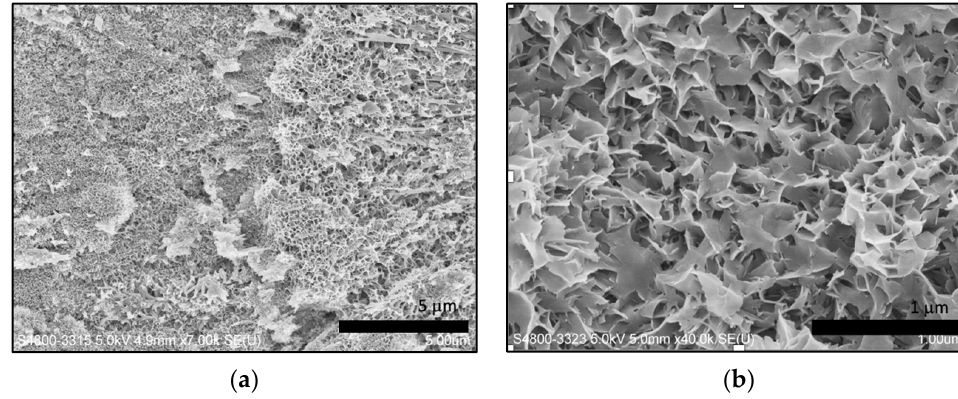
Figure 4. SEM micrograph of remineralized dentin surface in the experimental group without addition of GO: ( a ) with 7.00 k × magnification; ( b ) with 40.0 k × magnification.